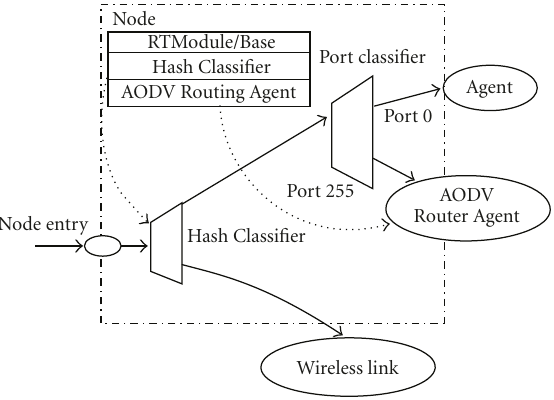
Figure 8: Architecture of a wireless node in NS-2.